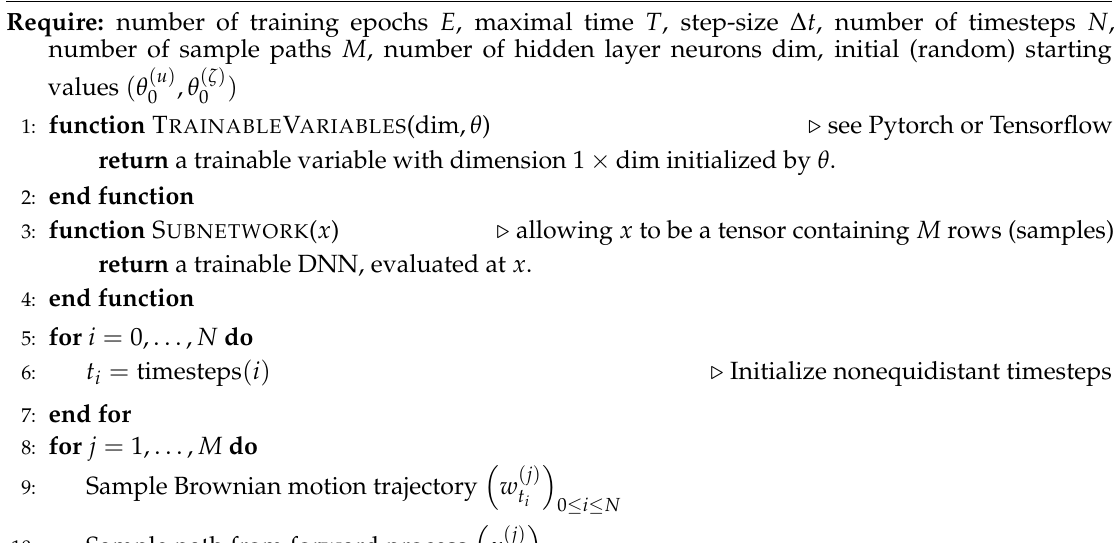
Algorithm 1 Elliptic PDE Solver for a BSDE ( f , ξ ) with stopping time